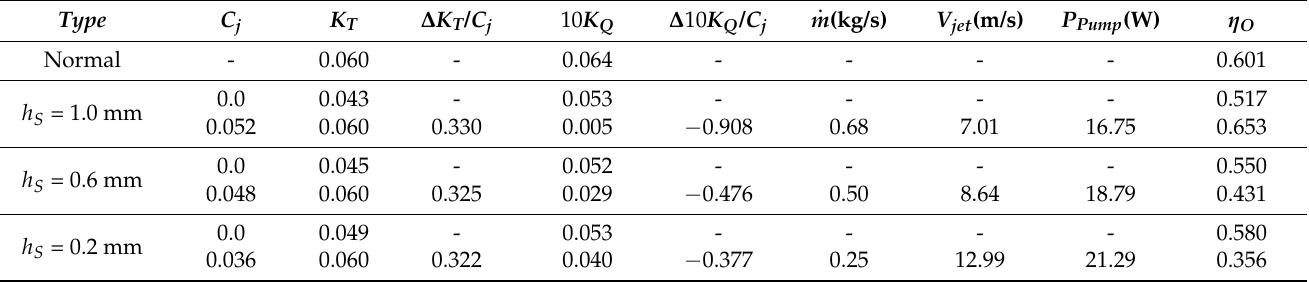
Table 8. Performance comparison of Coanda propeller with thrust identify of normal propeller (NACA66 (MOD, t/c = 0.12)).